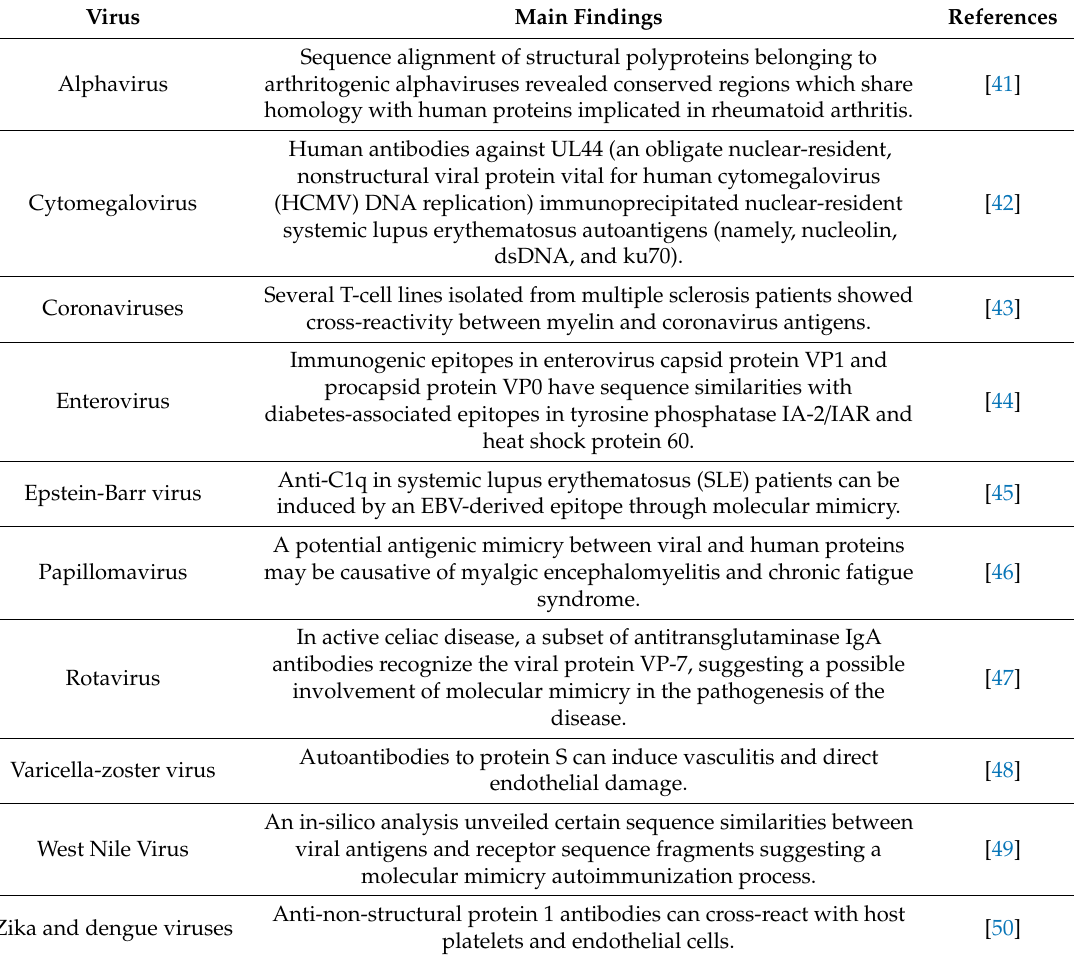
Table 3. Examples of molecular mimicry involving viruses in